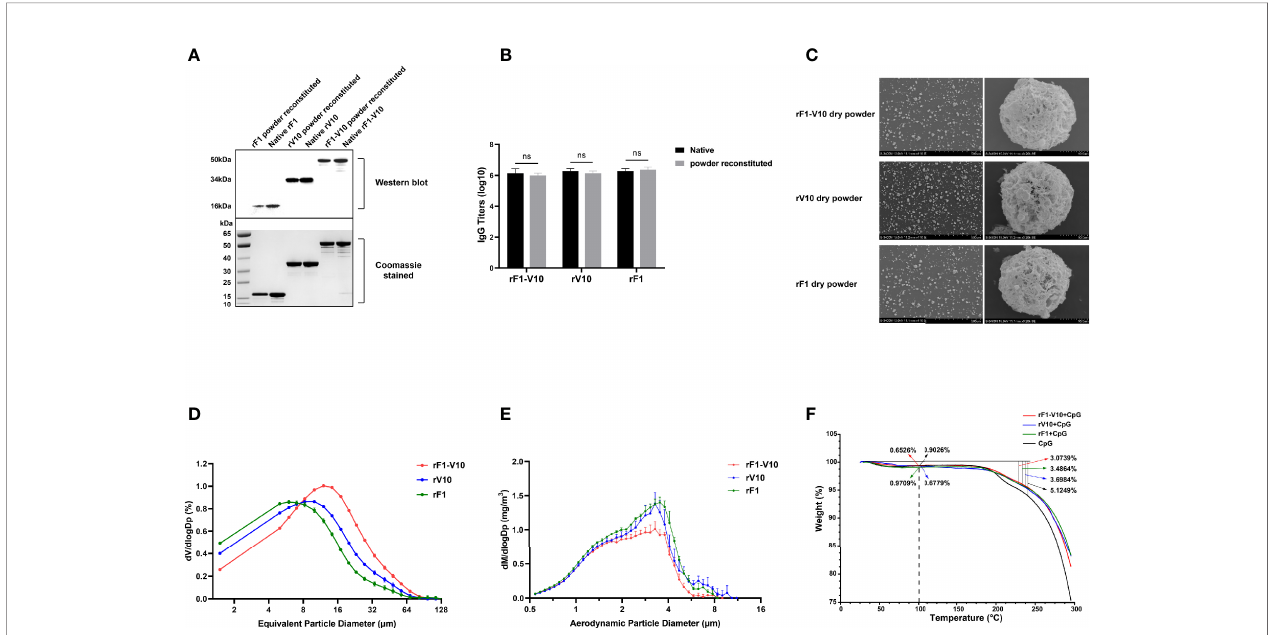
FIGURE 3 | Characterization of rF1, rV10 and rF1-V10 dry powders. (A) Dry powders and liquids of three vaccines were analyzed by Western blot using sera collected from cognate antigen immunized mice (upper panel). A protein gel stained with Coomassie brilliant blue was used as a loading control (lower panel). (B) The immunogenicity of dry powder and liquid vaccines measured by ELISA, using sera collected from cognate antigen immunized mice. (C) Scanning electron microscopy pictures of the three vaccine dry powders. (D) VMD of the aerosolized vaccine dry powders, as determined using a laser particle size analyzer. (E) MMAD of the aerosolized vaccine dry powders, as measured using a TSI APS 3321. (F) TGA of the three vaccine dry powders. ns, no statistical signi fi